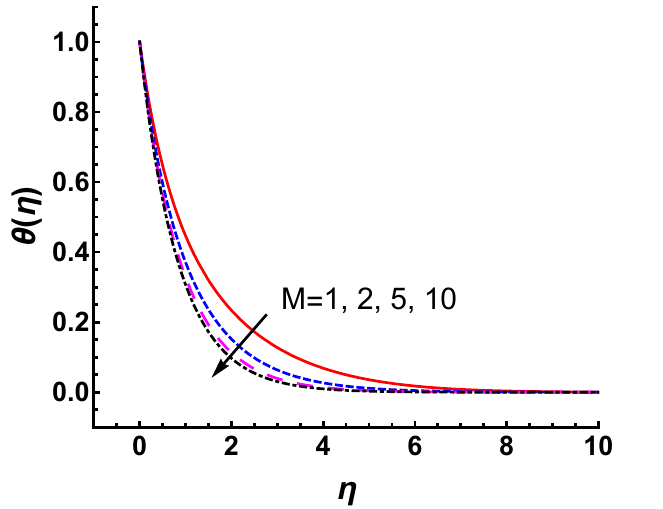
Figure 10. Influence of M parameter on temperature profile θ ( η ) with γ = 1, s = 2, Pr = 0.71; line: HAM results, marker: numerical